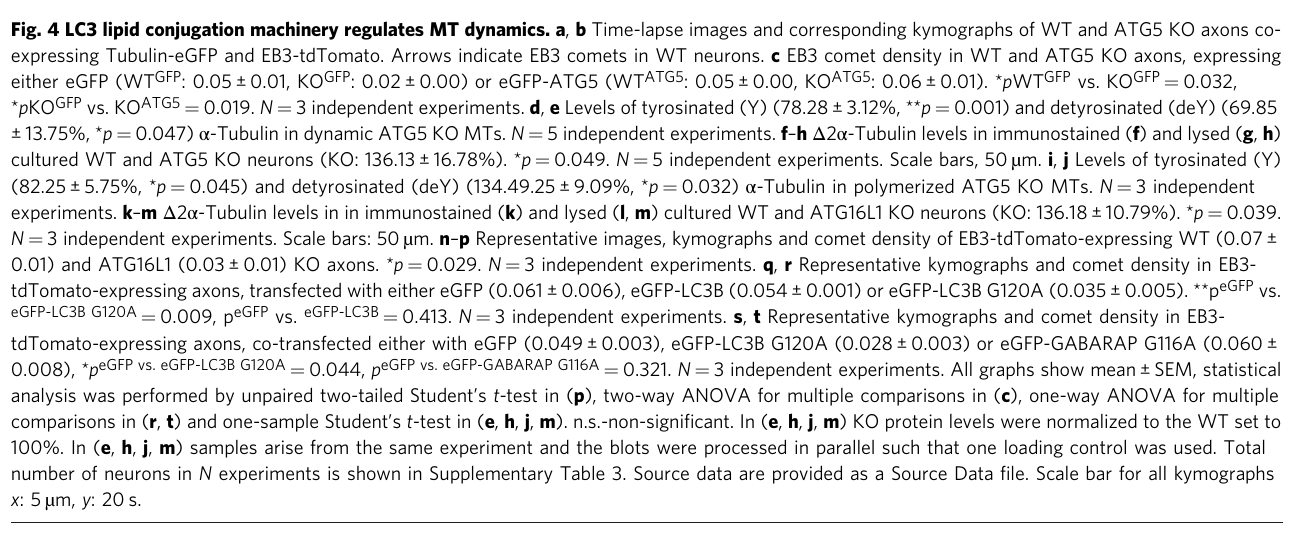
Fig. 4 LC3 lipid conjugation machinery regulates MT dynamics. a , b Time-lapse images and corresponding kymographs of WT and ATG5 KO axons co- expressing Tubulin-eGFP and EB3-tdTomato. Arrows indicate EB3 comets in WT neurons. c EB3 comet density in WT and ATG5 KO axons, expressing either eGFP (WT GFP : 0.05 ± 0.01, KO GFP : 0.02 ± 0.00) or eGFP-ATG5 (WT ATG5 : 0.05 ± 0.00, KO ATG5 : 0.06 ± 0.01). * p WT GFP vs. KO GFP =